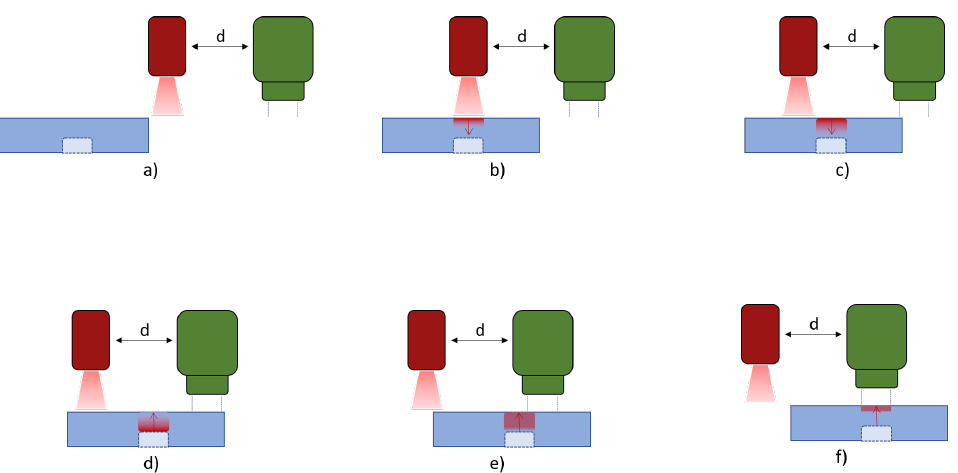
Figure 4. The distance between the heat source and the thermal camera has utter importance in maximising the temperature difference between a sound region and a defect region. The heat wave injected in the sample to be inspected needs an amount of time to reach the defect and to reflect towards the surface. This period is dependent on the depth of the defect and the material properties. A visualisation of the travelling heat wave in an optimised scenario can be seen in multiple steps starting at subfigure ( a – f